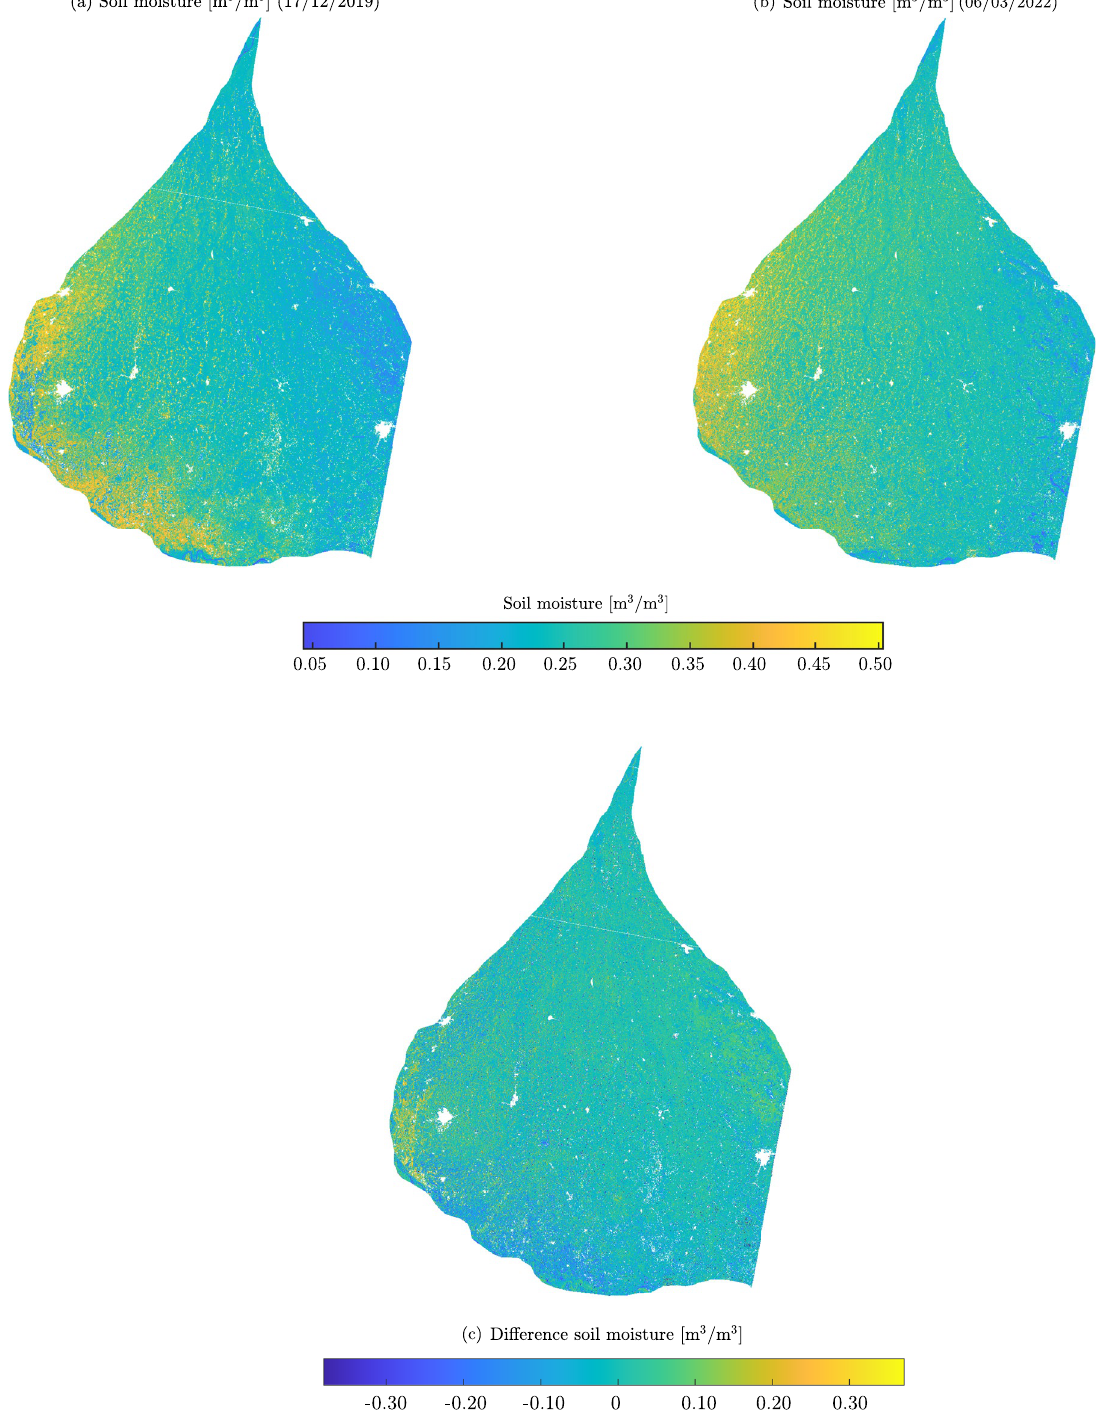
th December 2019 and ( b )